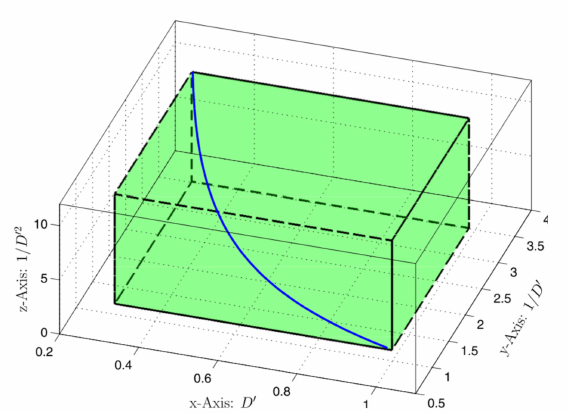
Figure 2. Plot of nonlinear uncertainty function (f(D’)) (solid line) and three-dimensional projection of the polytope P 2009 (dashed line), as in